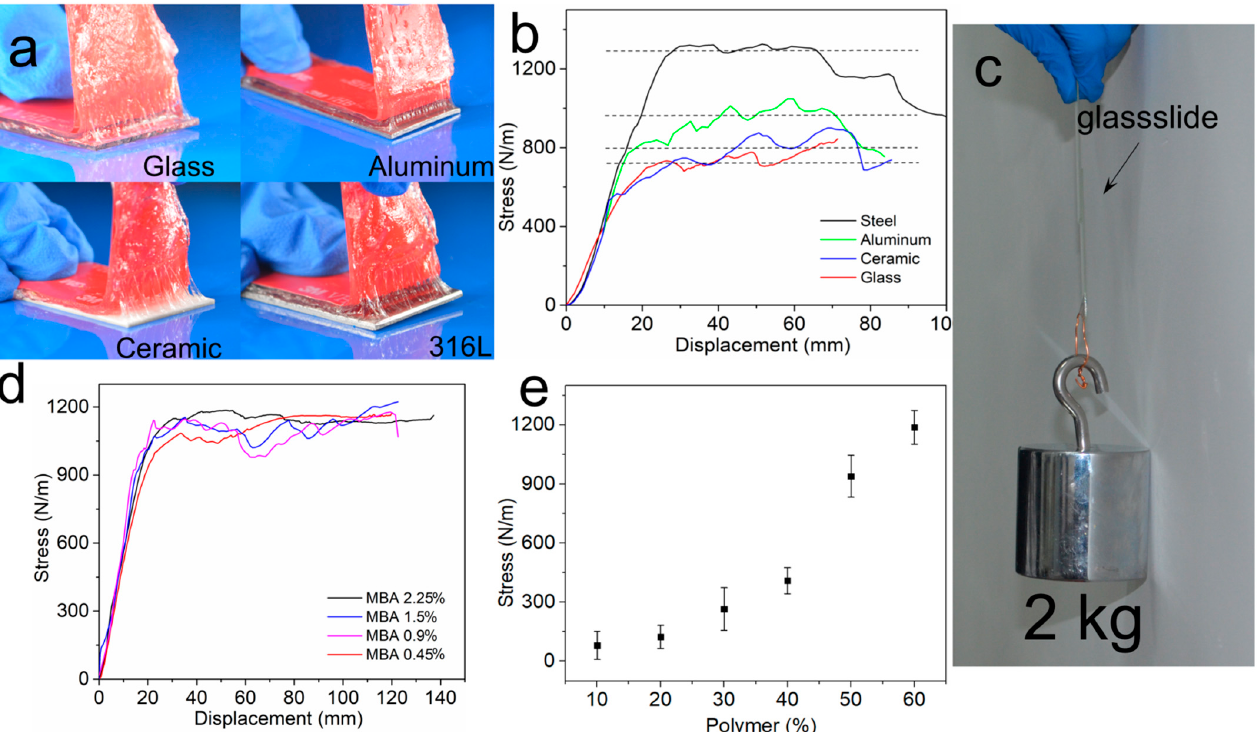
Figure 3. ( a ) Photos of the peeling process of the AEtMA-Cl-based layer physically attached on four solid substrates: glass, aluminum, Al 2 O 3 ceramic, and 316L stainless steel. ( b ) Stress–displacement curves of the layer on the different surfaces. ( c ) Photograph of AEtMA-Cl-based hydrogel between two glass slides bearing a 2 kg load. ( d , e ) The adhesion of AEtMA-Cl hydrogels with different crosslinker contents and polymer concentrations by 90 ◦ peeling